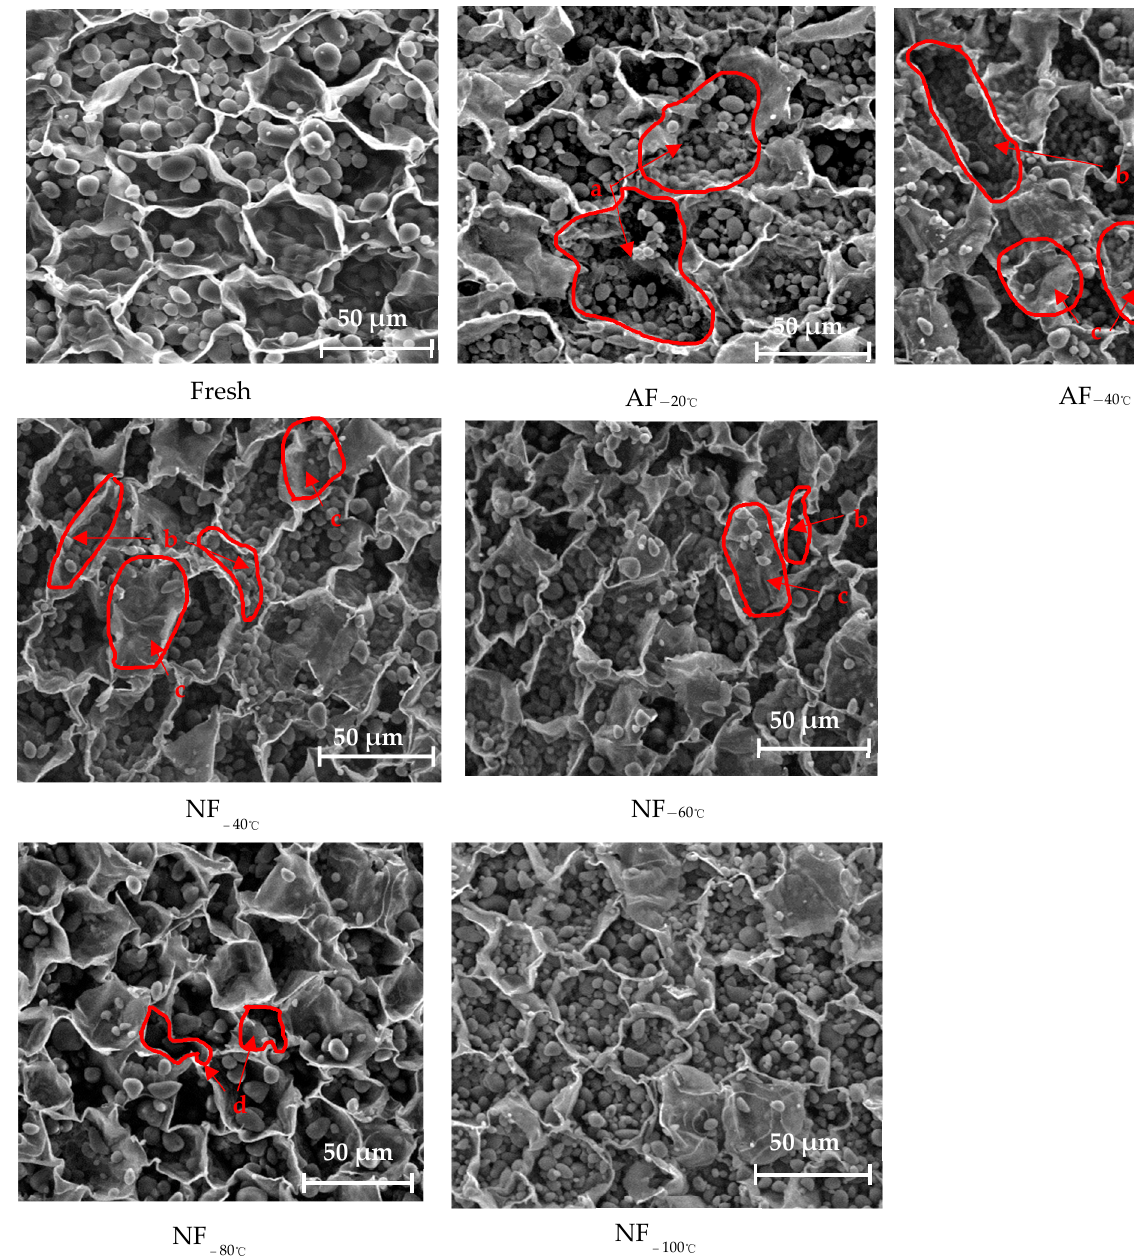
Figure 6. Microstructure of chestnut kernels treated by di ff erent freezing methods. a: collapse and puncture, b: cell gap, c: collapse, d: shrinkage. The SEM observation was carried out at a magni fi ca- tion of 200 times.